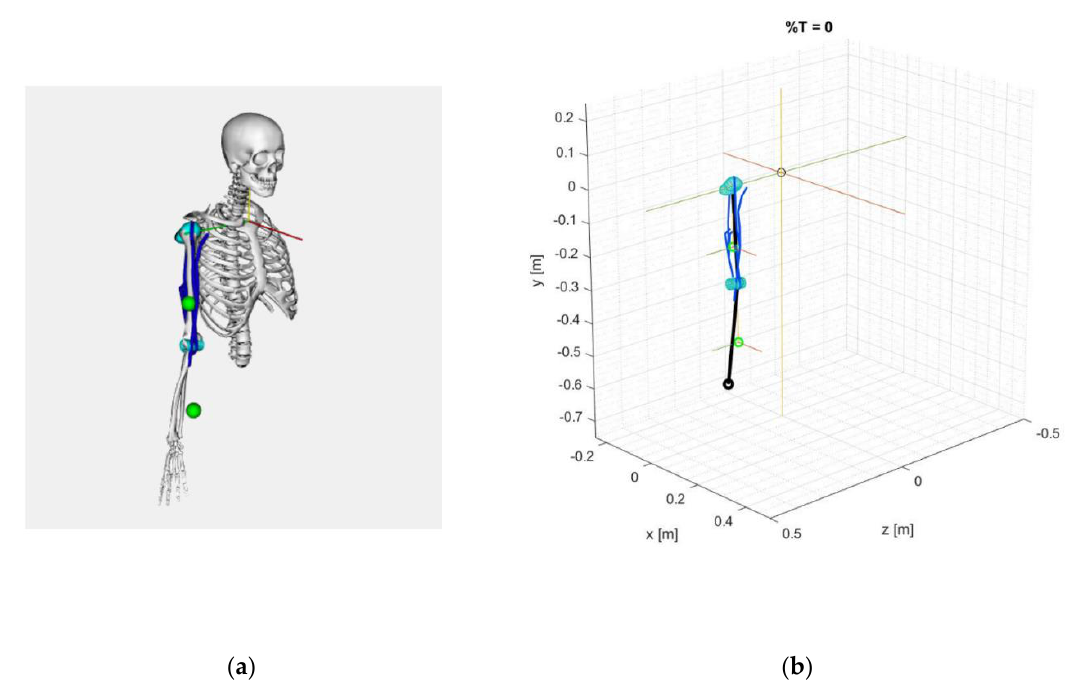
Figure 8. Kinematics first time instant in ( a ) OpenSim and ( b ) Matlab.